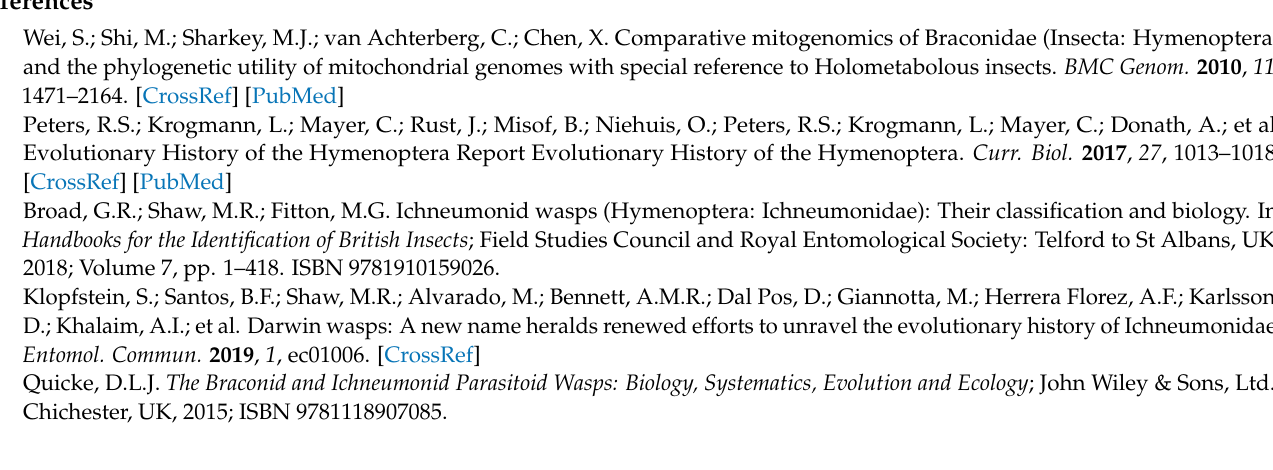
Figure S2: Phylogenetic relationships of Ichneumonidae inferred from nucleotides (NU) sequences of 13 protein-coding genes in mitochondrial genomes by ML methods; Figure S3: Phylogenetic relationships of Ichneumonidae inferred from amino acids (AA) sequences of 13 protein-coding genes in mitochondrial genomes by BI methods; Figure S4: Phylogenetic relationships of Ichneumonidae inferred from amino acids (AA) sequences of 13 protein-coding genes in mitochondrial genomes by ML methods. Table S1: Information for the samples sequenced in this study; Table S2: Best model list from PartitionFinder for seven subsets including 39 PCGs partitions (every PCG gene was Table S3: Best model list from ModelFinder for 39 individual PCGs partitions (every PCG gene was part to tree partions as p1, p2 and p3) and 13 AA partitions for IQtree: Table S4: Synonymous and nonsynonymous substitutional analysis of 13 protein-coding